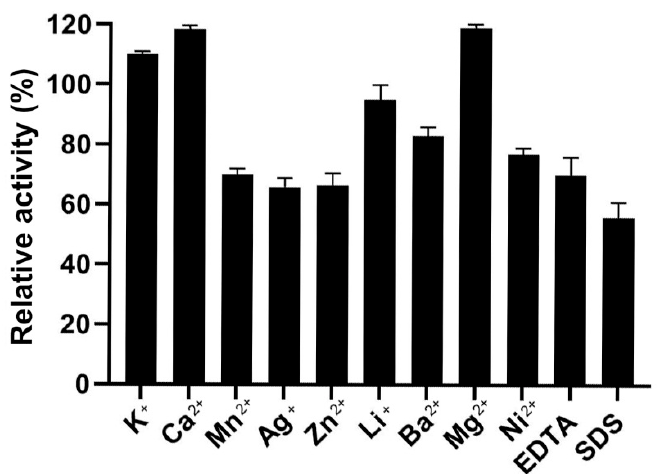
Figure 7. Effect of reagents on enzyme activity of YsHyl8A. Effects of metal ions, chelator (EDTA, 1 mM), and surfactant (SDS, 0.1%, w / v ). Error bars indicate the standard deviation ( n = 3).